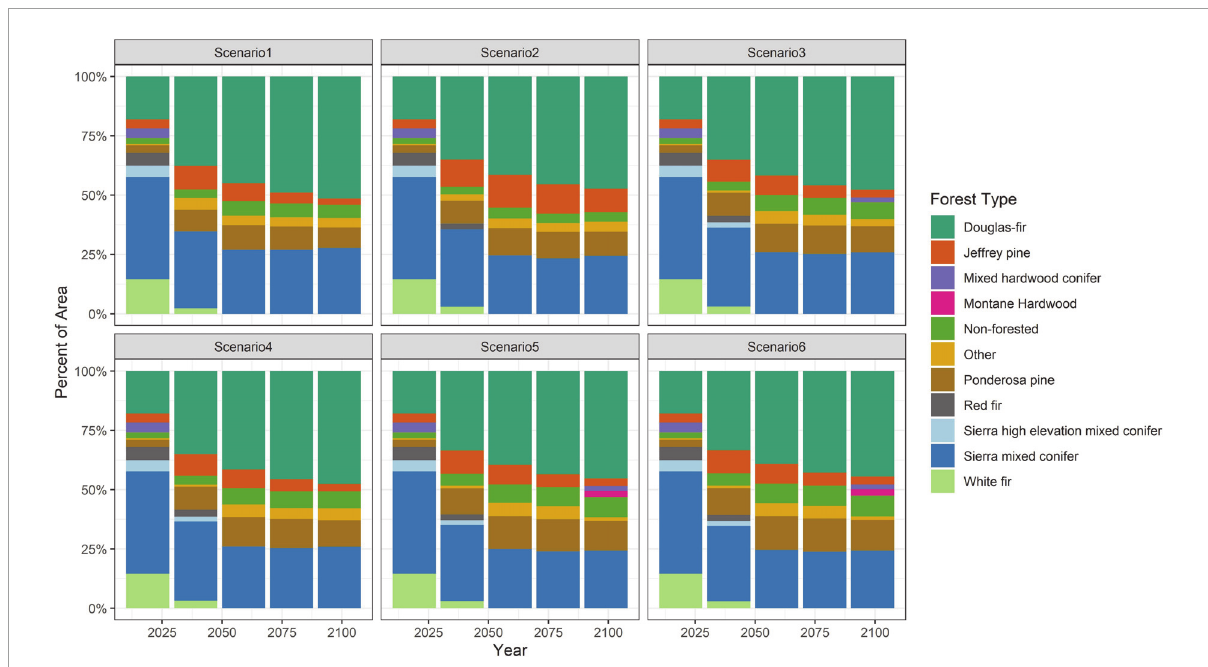
FIGURE5 Percent cover for the dominant forest types by management scenario using all replicates averaged across all climate projections.